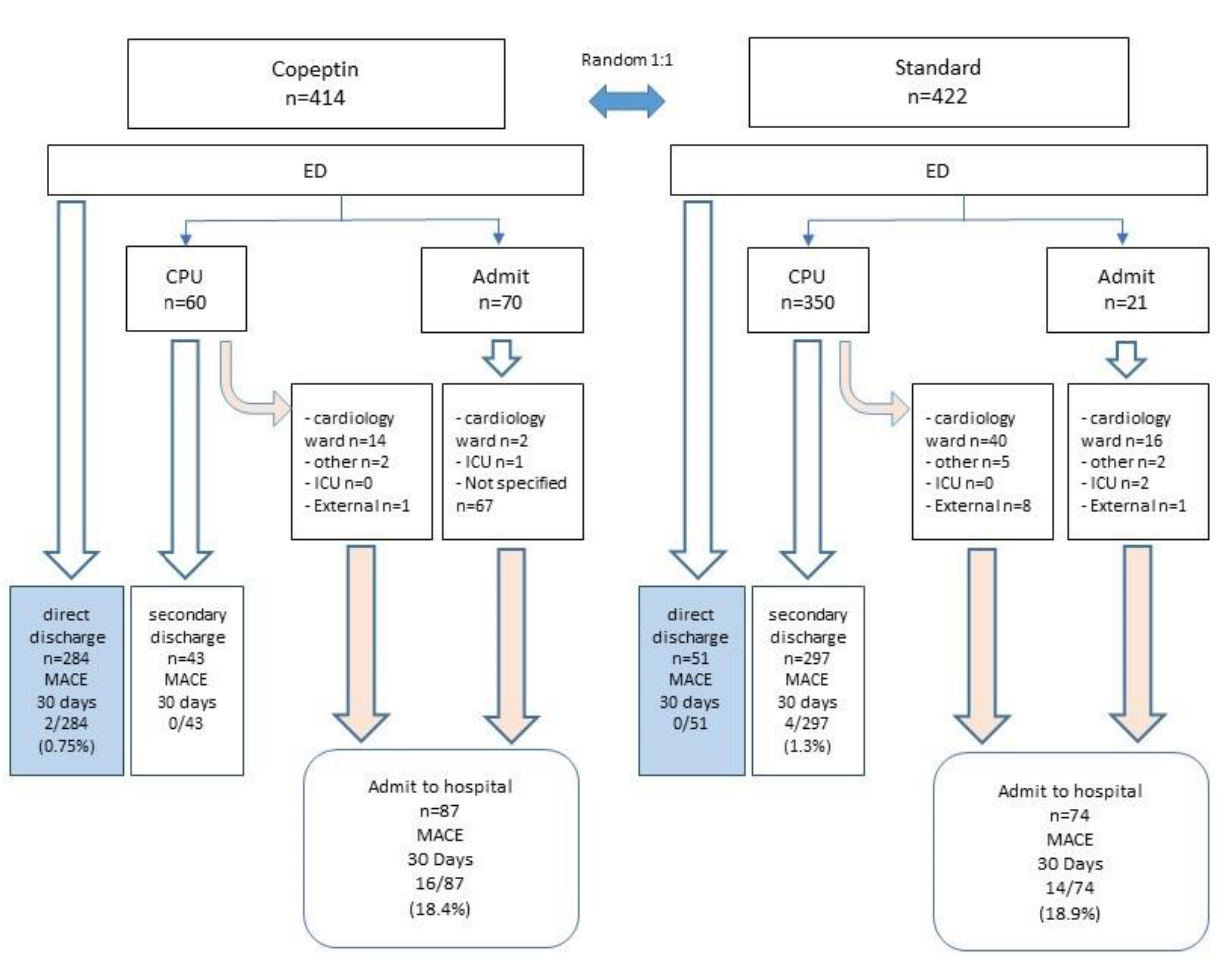
Figure 1. BIC-8 RE-VISITED. Patient disposition in randomized groups and MACE rates at 30 days. The numbers of cases in the corresponding boxes are displayed as absolute numbers and relative frequencies in